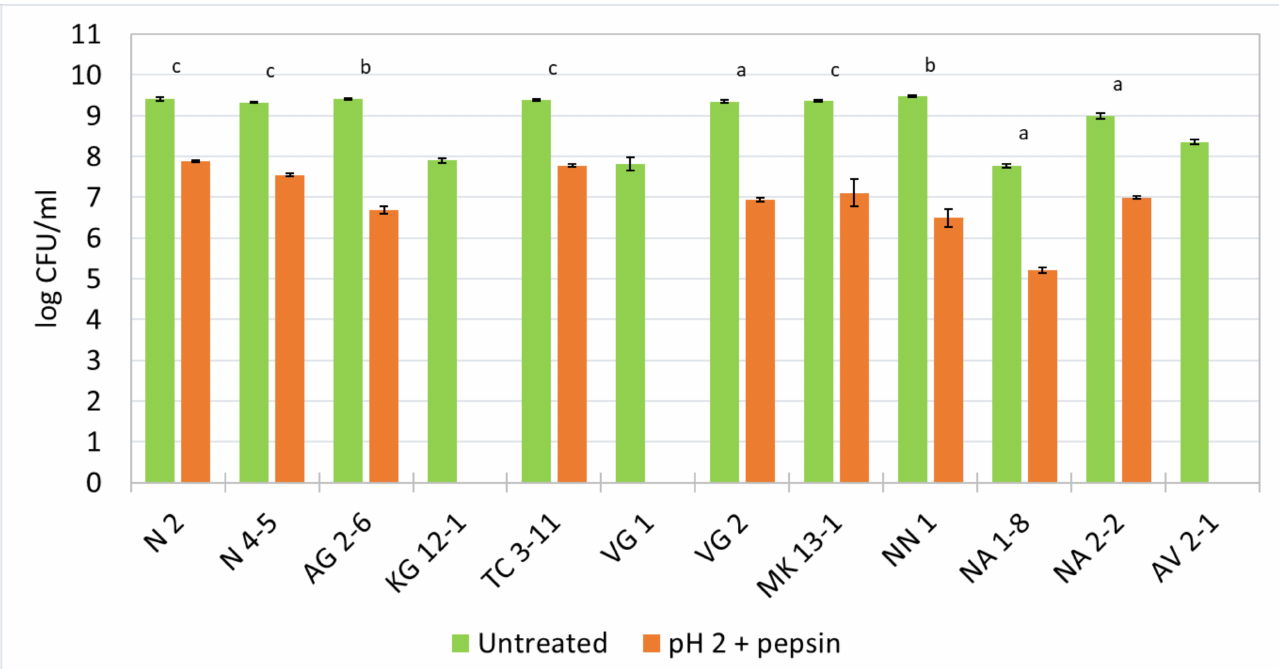
Figure 2. Survival ability of the newly isolated lactic acid bacterial strains in pepsin in pH 2. Means: a —nonsignificant ( p > 0.05); b and c —significant ( p < 0.05 and p < 0.01,